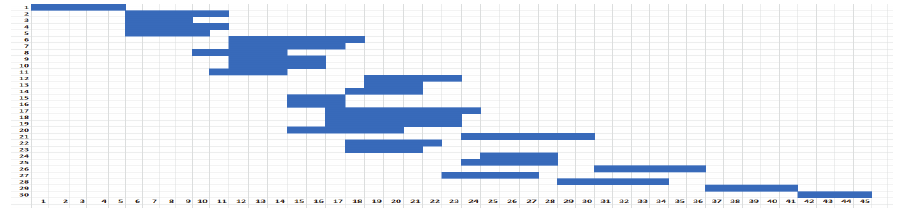
Fig. 5. Gantt chart of the experiment relaxed resource constraints